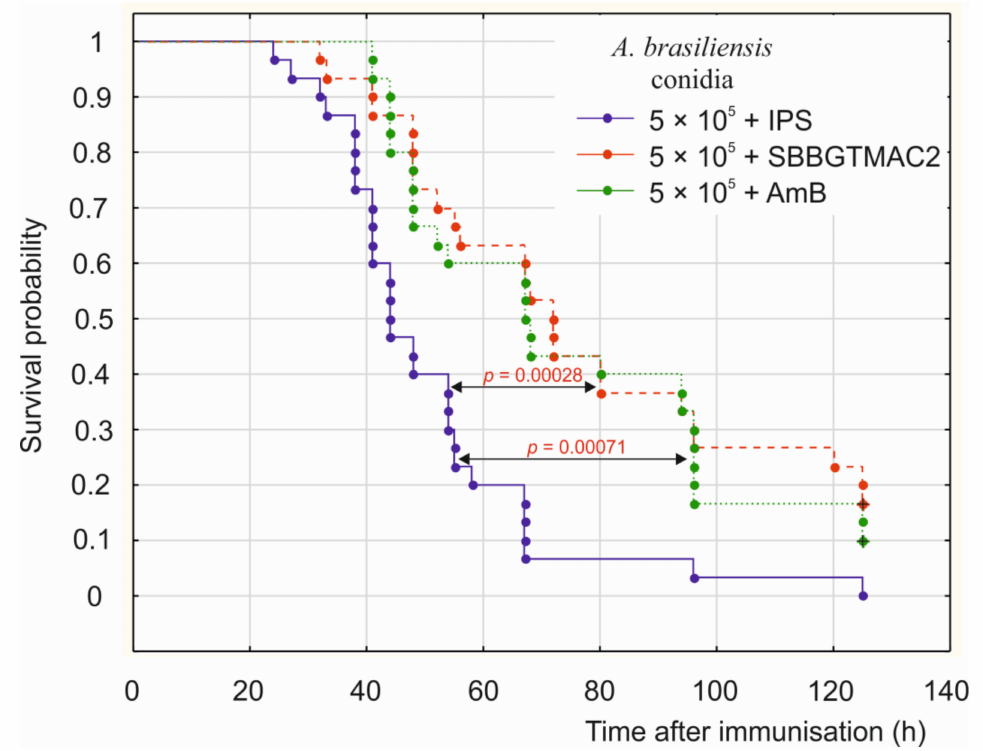
Figure 2. The effect of SBBGTMAC2 on survival of G. mellonella larvae infected with A. brasiliensis . The larvae were injected with suspension containing 5 × 10 5 of A. brasiliensis conidia and, after 2 h-incubation, with IPS (control) or SBBGTMAC2 or AmB. The larvae survival was evaluated, and survival probability was estimated using the Kaplan–Meier estimator. Survivability comparisons between control and two other groups were done using log-rank test. The effects of SBBGTMAC2 and AmB were comparable, as no statistically significant difference was found between these groups. The graph shows results from three independent